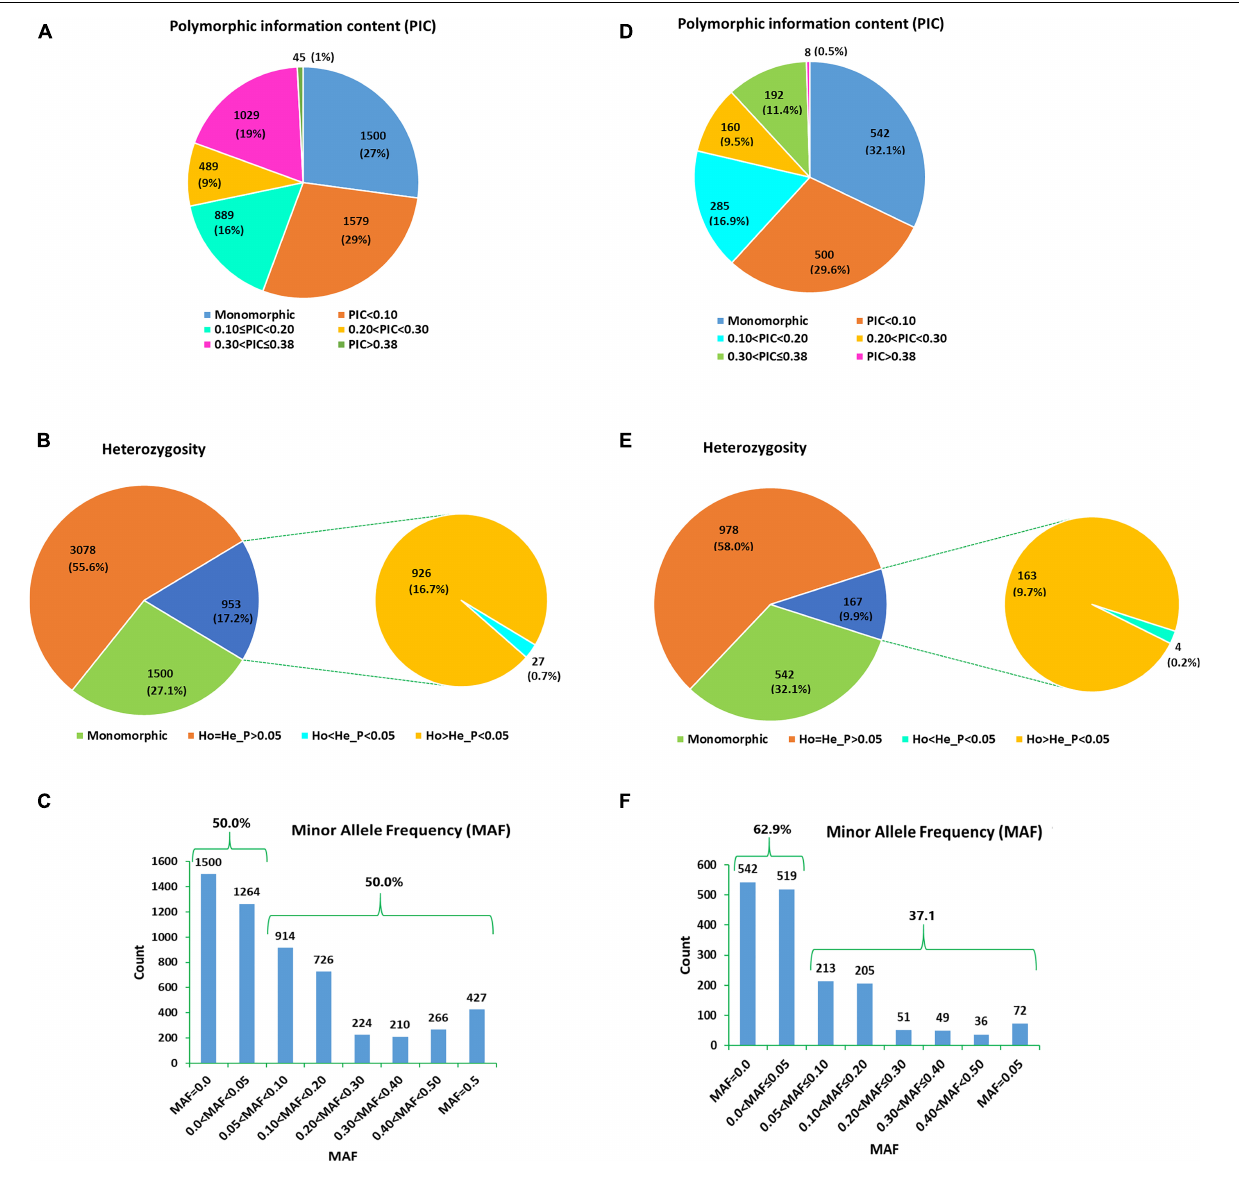
FIGURE 3 | Pie charts/bar graphs exhibiting the grouping of 5,531 SNP loci recorded across the 28 noug genotypes according to (A) their polymorphism information content (PIC), (B) heterozygosity, and (C) minor allele frequency (MAF); and the 1,687 SNP loci recorded across the 30 noug genotypes according to (D) their PIC, (E) heterozygosity, and (F)